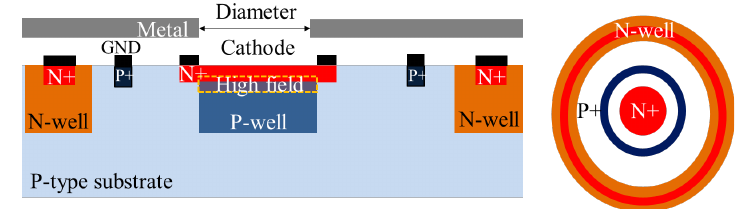
Figure 4. Cross-section and top view of the SPAD under